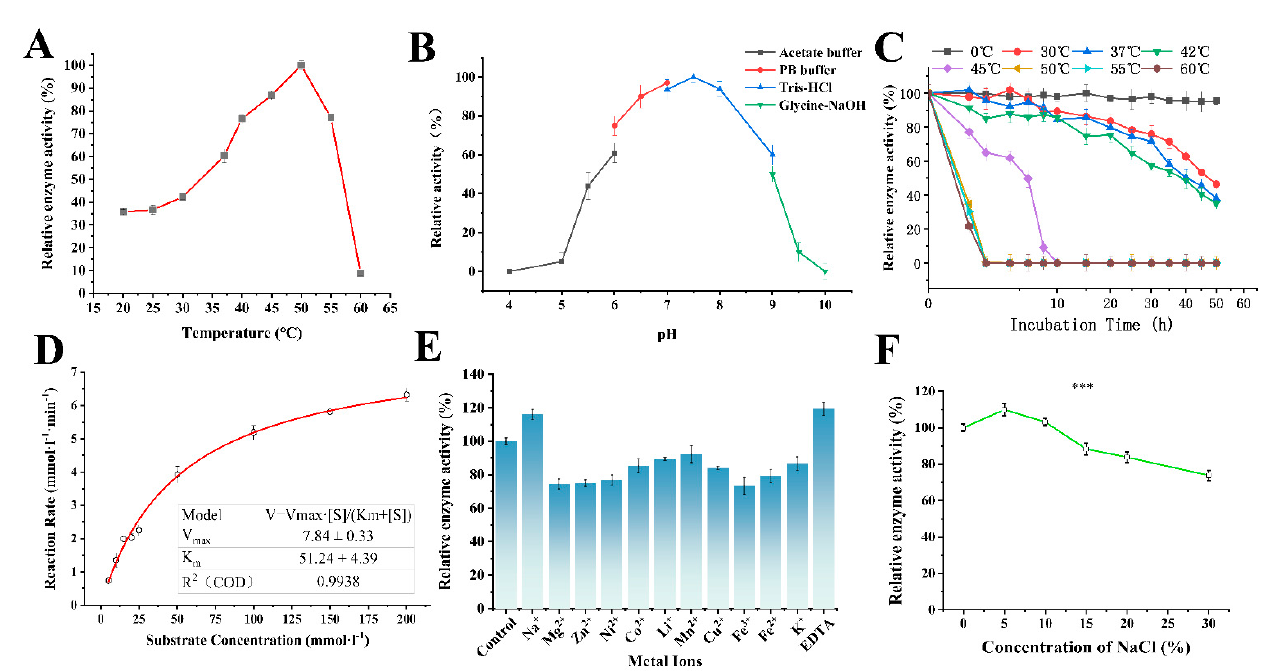
Figure 2. Enzymatic properties of LreuglsA. The activities are presented as relative values observed in various ranges, as described below. ( A ) Effect of temperature on LreuglsA activity. ( B ) Effect of pH on LreuglsA activity. ( C ) Effect of stability at different temperatures on LreuglsA activity. ( D ) Enzyme kinetic fitting. The Michaelis–Menten equation was applied using the Origin nonlinear fitted Hill function ( n = 1). ( E ) Effect of metal ions on LreuglsA activity. ( F ) Effects of salt concentrations on the glutaminase activity of LreuglsA. Each experimental data point represents the average of three independent experiments, and the error bars indicate standard deviations. *** p < 0.005.